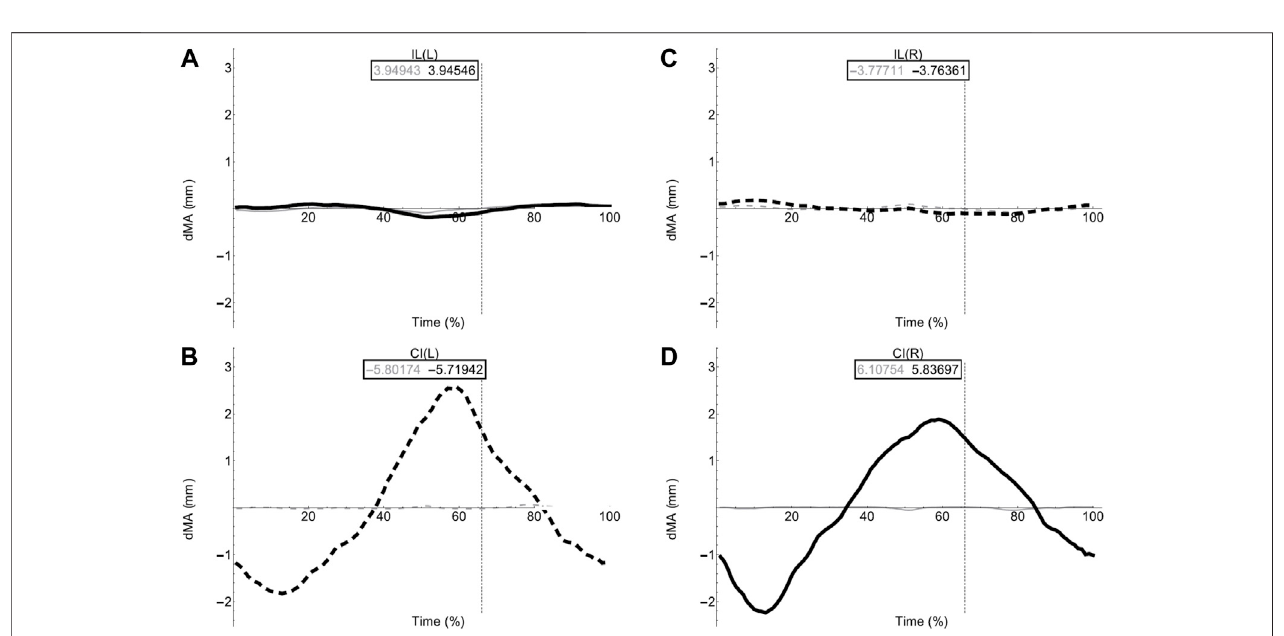
FIGURE 7 | Axial muscle moment arms during walking. Changes in moment arm (dMA) versus time are shown for (A) the left Iliolumbaris, IL (L), (B) left coccygeoiliacus, CI (L), (C) right Iliolumbaris, IL (R), (D) right coccygeoiliacus, CI (R) for simulations with a mobile pelvis (natural condition; black) versus a fi xed pelvis (simulated condition; grey). See Figure 3 caption for further details. Solid versus dashed lines represent positive moment arms ( fl exion — femur protraction) versus negative (extension — femur retraction) such that a change from solid to dashed indicates a change in muscle function.